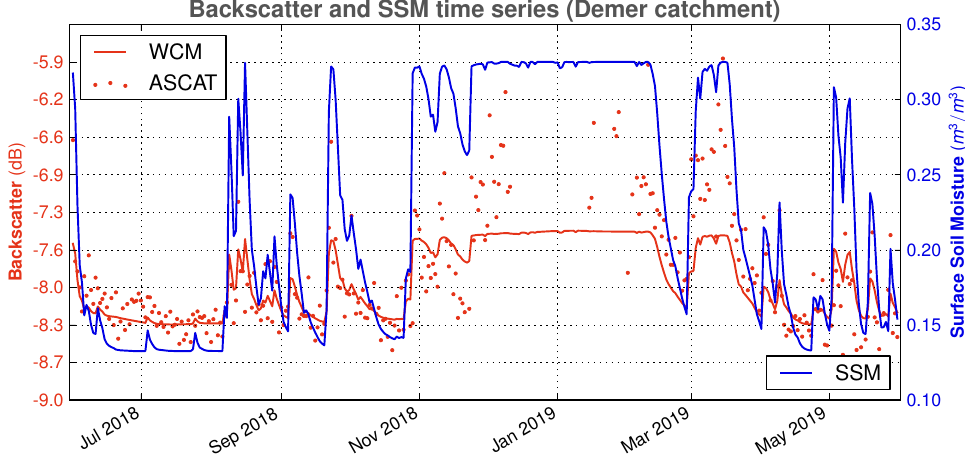
Figure 12. Spatially averaged backscatter, simulated (WCM) and observed (ASCAT) and SSM (deterministic SCHEME run) for the Demer catchment, June 2018–May